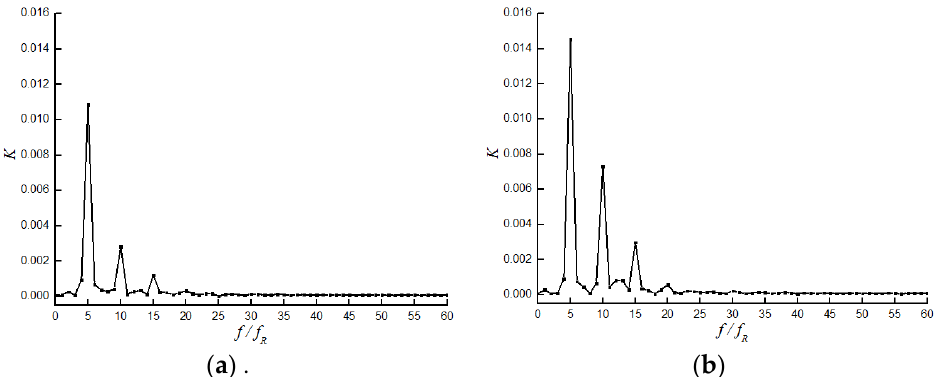
Figure 16. Frequency domain results of radial hydraulic forces. ( a ) Pump impeller. ( b ) Pump volute.